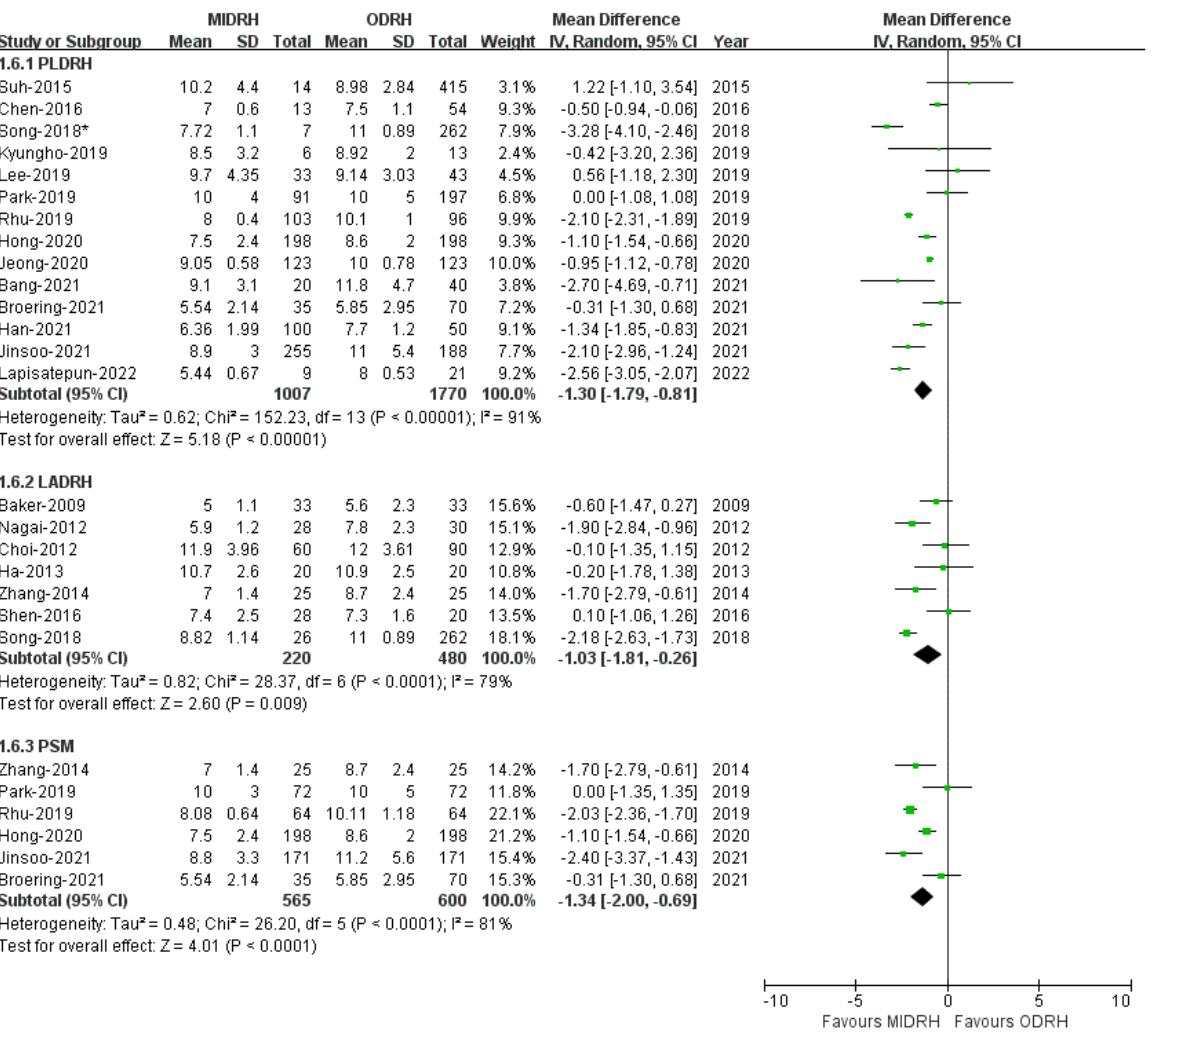
Figure 6. Forest plot and funnel plot comparison of MIDRH versus ODRH for length of